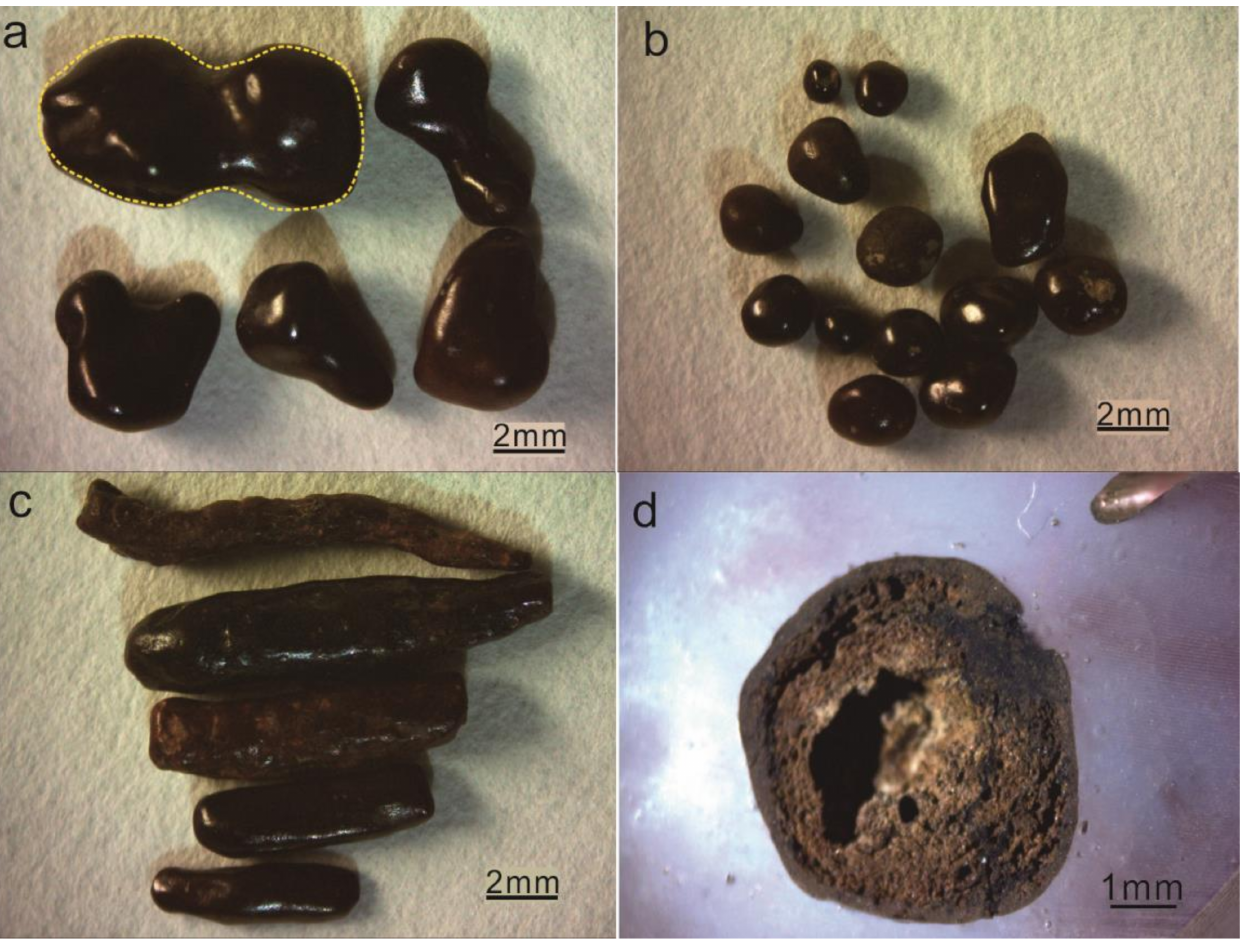
Figure 4. Photographs of iron-rich spherules under stereomicroscope. ( a ) The shapes of the iron-rich spherules include ball-shaped, cone-shaped, spindle-shaped, ellipsoidal and teardrop-shaped. ( b ) Millimeter-sized iron-rich spherules with similar and slightly different shapes. ( c ) Small rod-shaped concretions with many pits. ( d ) The cross-section of a spherule showing the structure inside of one spherule with a big cavity and many smaller